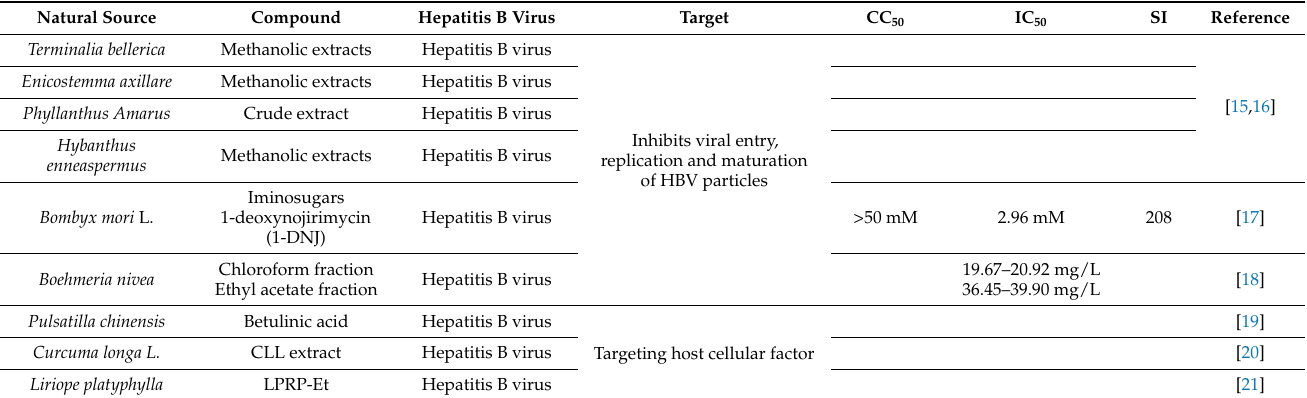
Table 1. Natural compounds and their antiviral targets against Hepatitis B